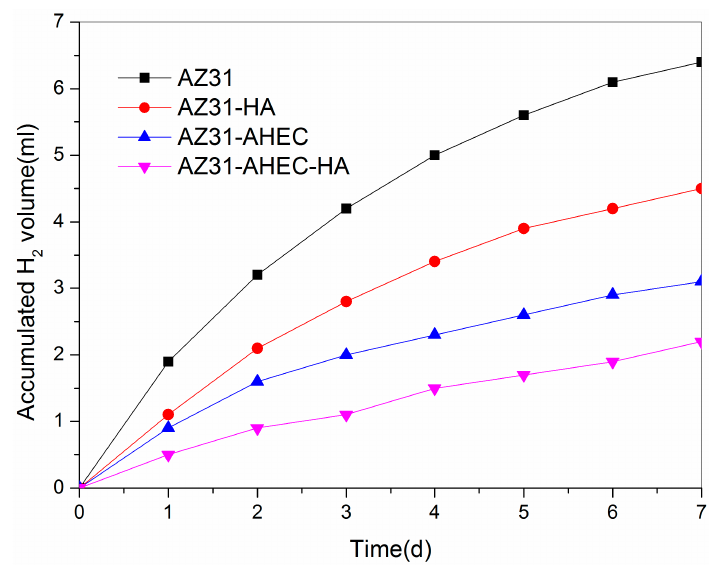
Figure 6. The line chart of cumulative hydrogen gas for the uncoated and coated samples in SBF for seven days.